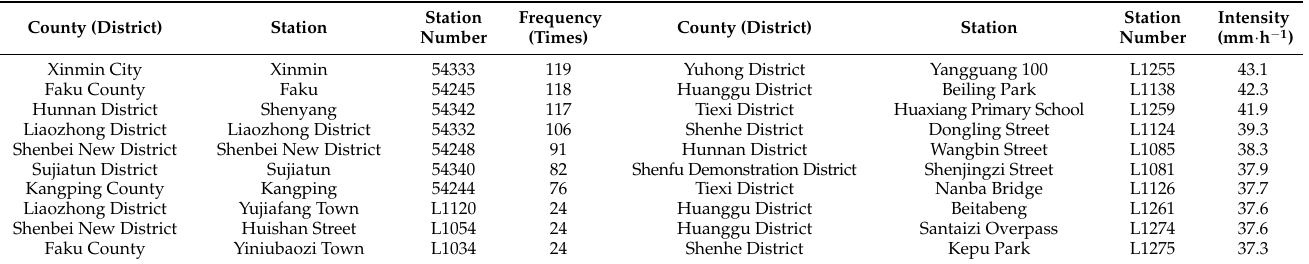
Table 2. National and regional stations with the top 10 ExHP frequencies and